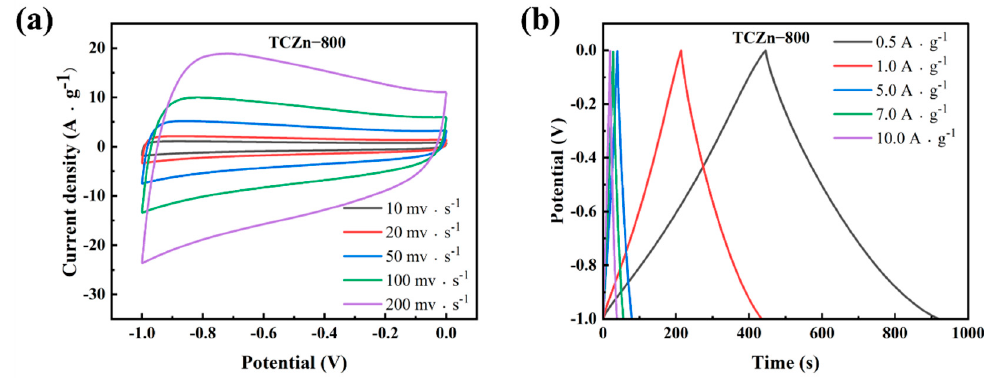
Figure 6. ( a ) CV curves at different scan rates and ( b ) GCD curves at different current densities of TCZn-800.